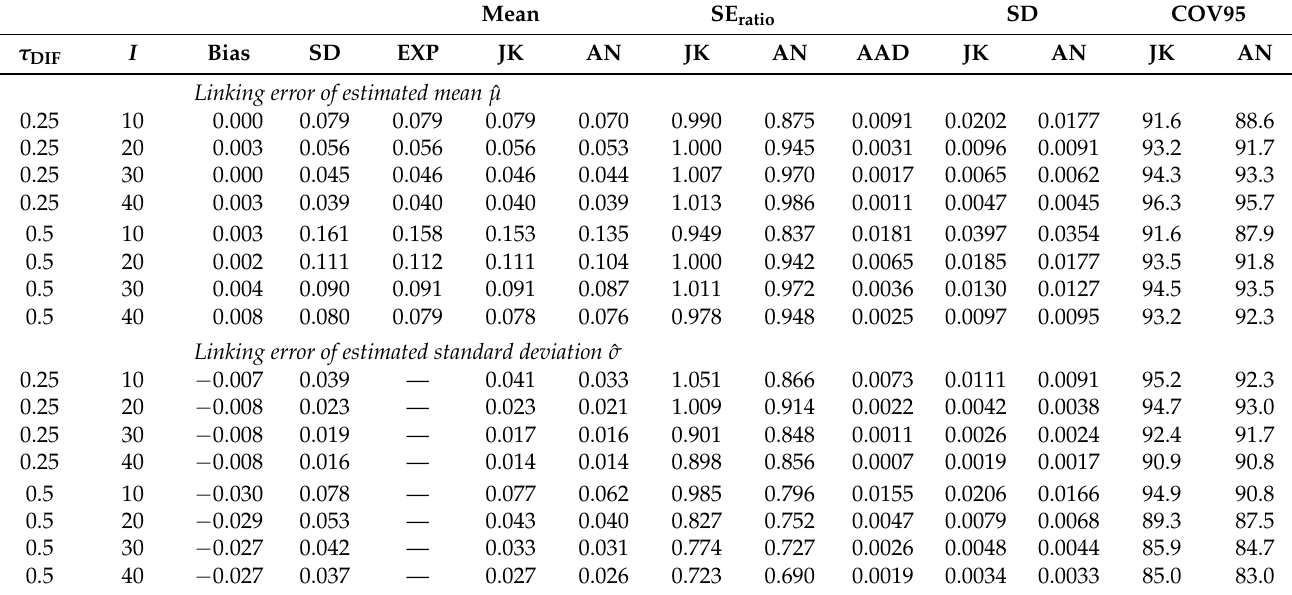
Table 1. Simulation study: Results as a function of the standard deviation of DIF effects ( τ DIF ) and number of items ( I